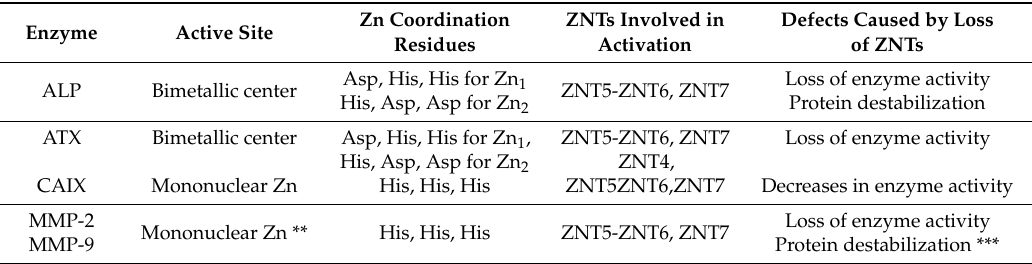
Table 1. Relationship between properties of zinc-requiring enzymes and ZNT transporters *.